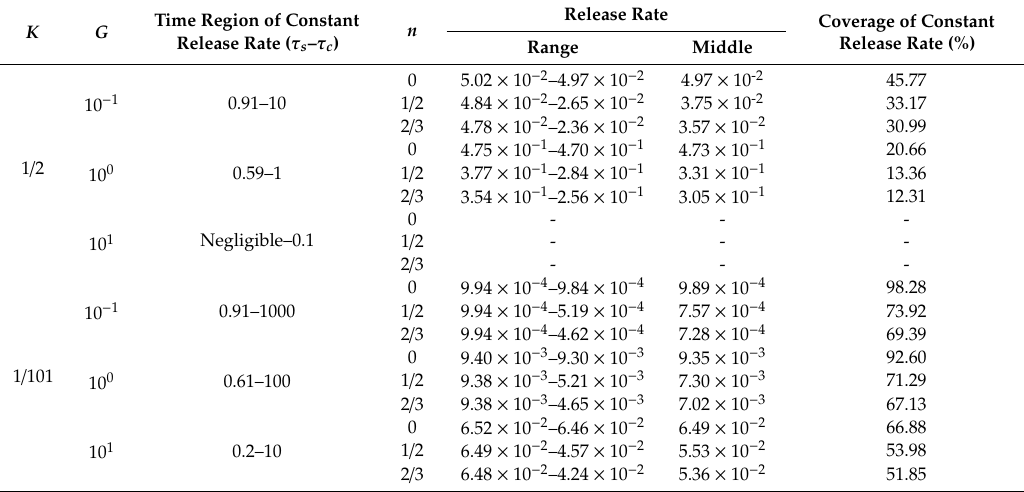
Table 1. The characteristics of the constant release rate for di ff erent K and G values in Figure